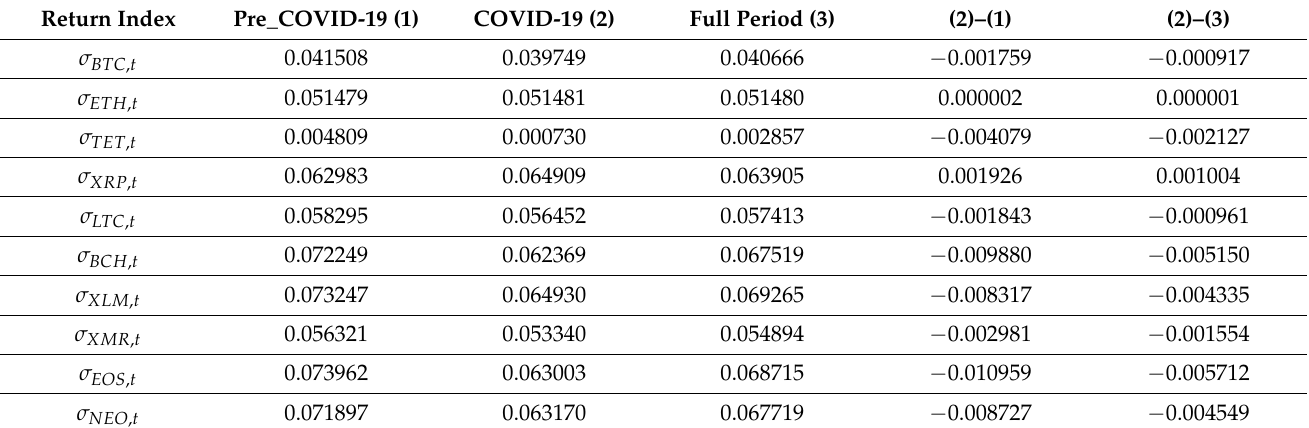
Table 9. Comparison of average GARCH values of the 10 cryptocurrencies’ return indices for the three